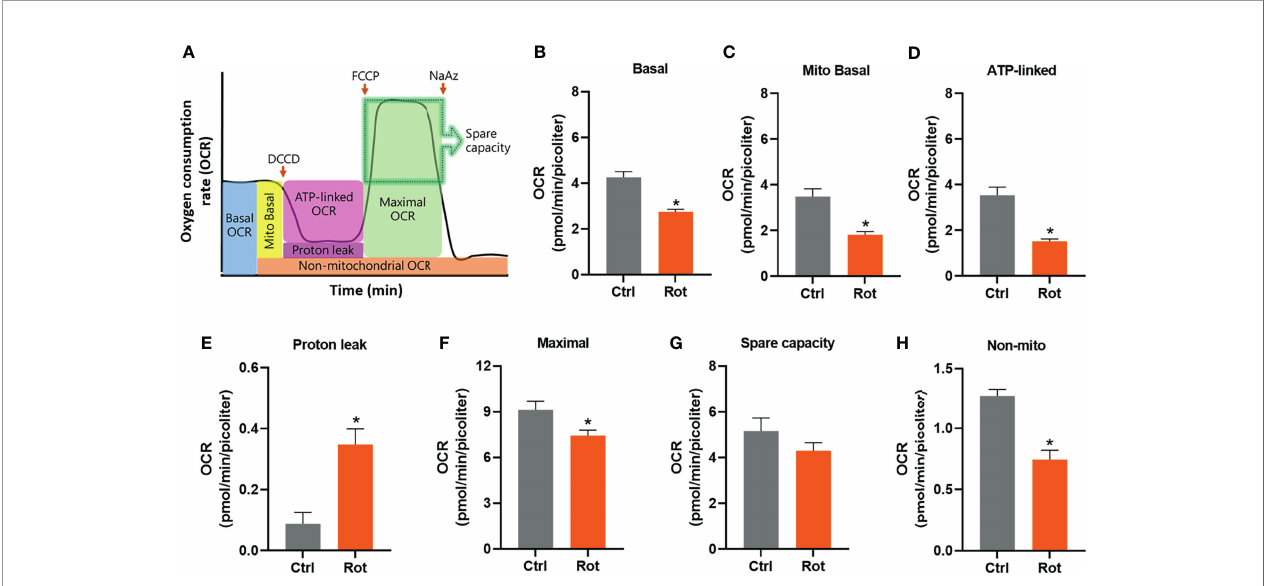
FIGURE 3 | Rotenone disrupts C. elegans mitochondrial function. Solvent control (Ctrl) and rotenone-exposed (Rot) nematodes were assessed for oxygen consumption using a Seahorse XFe24 bioanalyzer as described in the methods. Oxygen consumption rates (OCR) were normalized to the average nematode volume within each experiment. (A) Representative image of the mitochondrial function parameters assessed using the inhibitors dicyclohexylcarbodiimide (DCCD), carbonyl cyanide 4-(tri fl uoromethoxy) phenylhydrazone (FCCP), and sodium azide (NaAz). (B) Total basal OCR, (C) mitochondrial basal OCR, (D) ATP-linked OCR, (E) proton leak, (F) maximal OCR, (G) spare respiratory capacity, and (H) non-mitochondrial OCR are presented. Student ’ s T-test was performed for each parameter. Bars represent mean ± SEM. * represent signi fi cant difference (p < 0.05) between